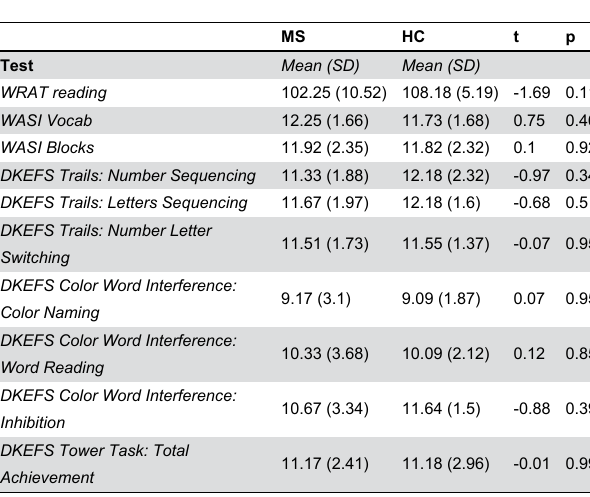
Table 1. Experiment 1: Means, Standard Deviations, t- values for performance on neuropsychological tests.